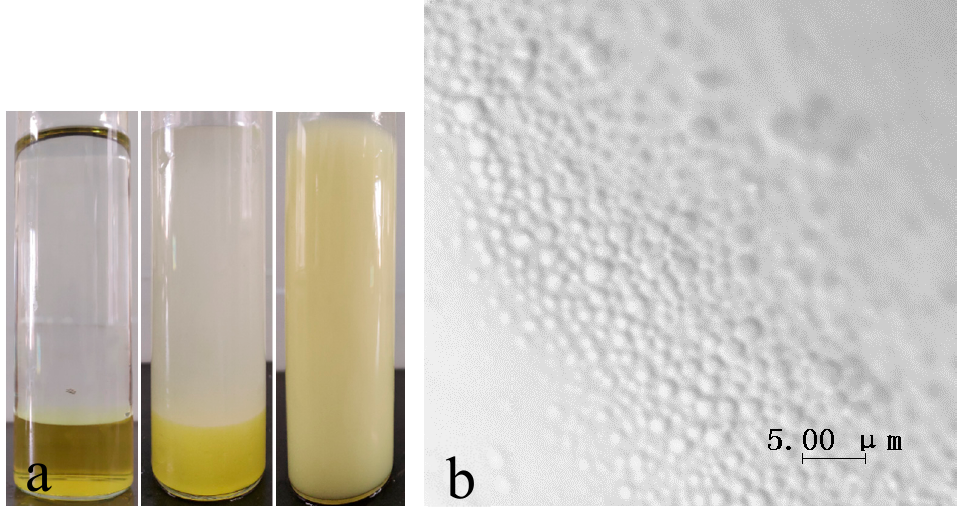
Figure 3. ( a ) Photographs of two-phase system. The left is before mixing, the middle is without emulsifier, the right is with emulsifier. ( b ) Microphotograph of water droplets in macroemulsion.